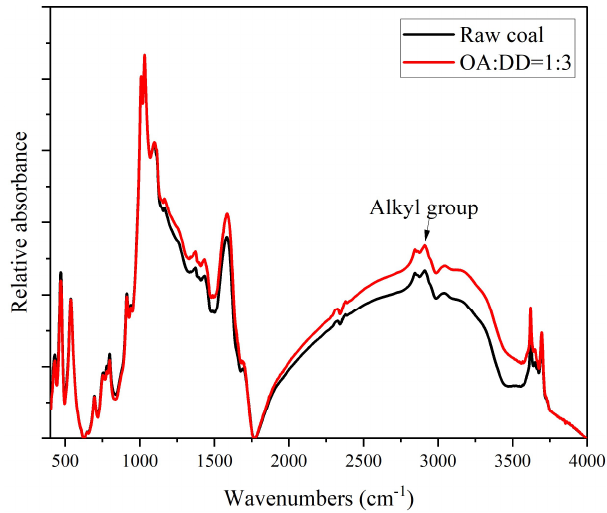
Figure 4. FTIR results of coal samples treated with OA:DD = 1:3 compound collector and raw coal.